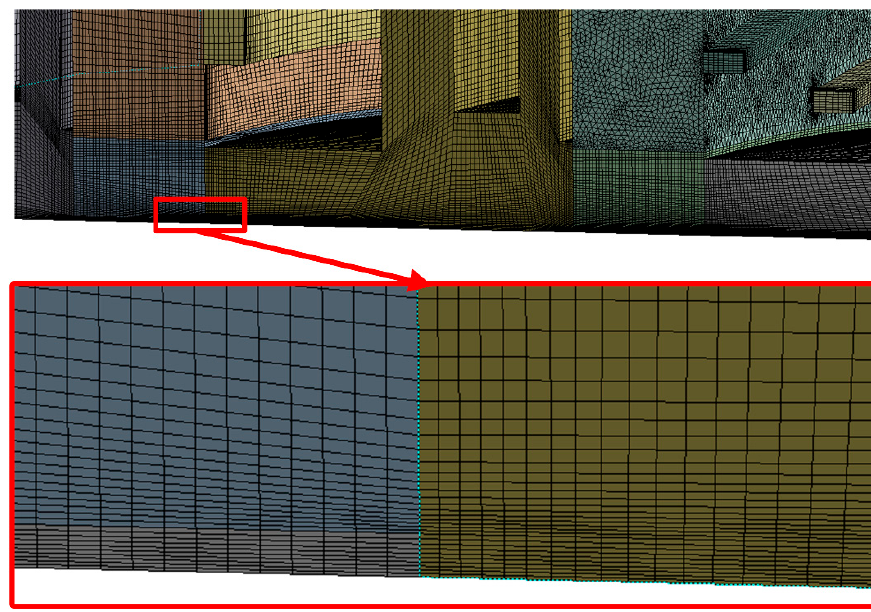
Figure 5. Sample mesh view.